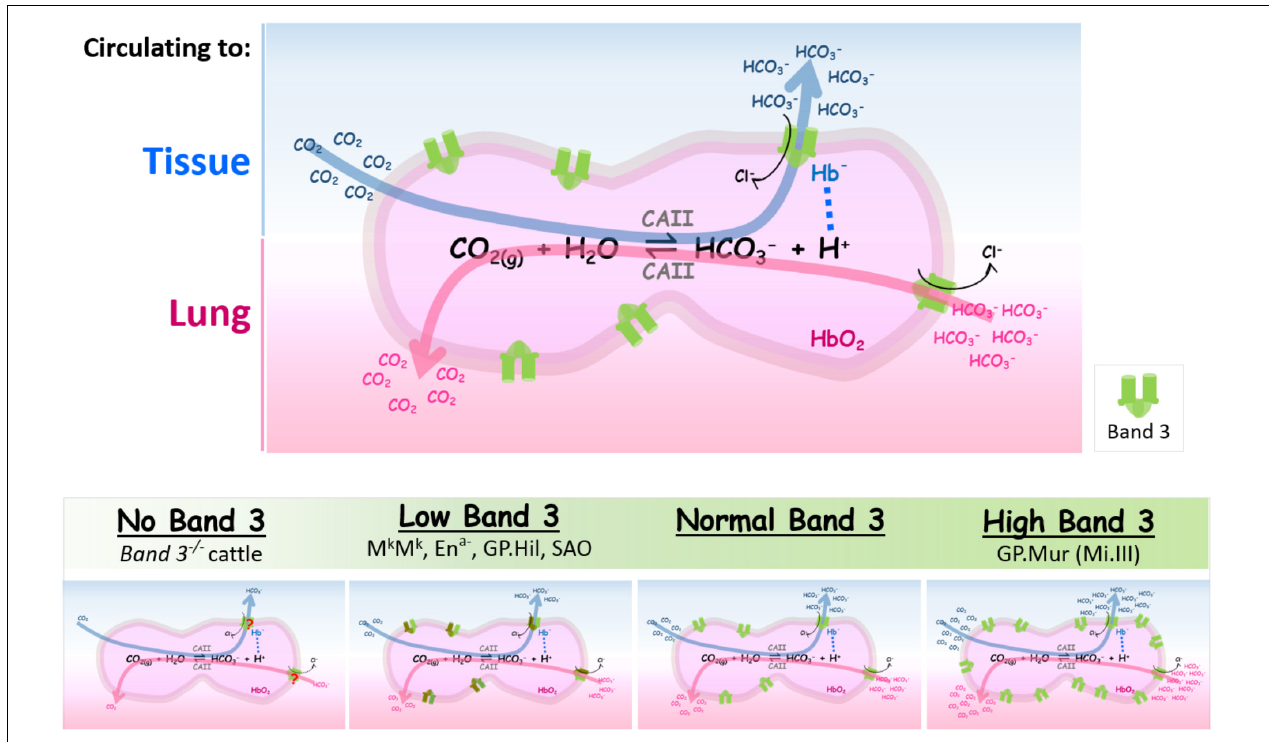
FIGURE 2 | The expression levels of band 3 are directly correlated with the efficiencies of blood CO 2 /HCO 3 − exchange. (Top) Intraerythrocytic CO 2 /HCO 3 − exchange in tissues or in lung alveoli is summarized in the reversible chemical reaction catalyzed by CAII [CO 2 ( g ) + H 2 O (cid:10) HCO 3 − ( aq ) + H + ( aq ) ]. When RBCs circulate to systemic capillaries, tissue metabolite CO 2 enters RBCs to be converted into HCO 3 − by intraerythrocytic CAII. HCO 3 − , one of the two products from this forward reaction, exits from RBCs through band 3 (shown by the blue arrow which indicates the direction of the reaction in tissues). The direction of the counterion Cl − flux through band 3 is indicated by a black arrow. Proton, the other product generated by the forward reaction, is absorbed by deoxy Hb − that is transiently associated with band 3 (shown by a dotted line connecting Hb − and H + ). When RBCs circulate to the lungs, HCO 3 − rushes into RBCs to be converted into CO 2 for expiration (shown by the pink arrow which indicates the reverse direction of the reaction). Band 3 is symbolized as the green dimeric gate. (Bottom) The spectrum of band 3 expression levels in RBCs is outlined in the shaded green bar; their differential impacts on blood CO 2 transport are illustrated in the four cartoon diagrams below. The four bottom diagrams from left to right: (1) Absence of band 3 reduces much HCO 3 − transport across the RBC membrane, rendering CO 2 /HCO 3 − exchange to be very inefficient. (2) Low band 3 expression can be found in some band 3/GPA mutations that result in semi-dysfunctional band 3 transporters, as described in the section of “Low or no band 3 expression” (shown here by the brown/green gate symbols for “structurally abnormal band 3”). (3) Normal band 3 expression. (4) Higher band 3 expression in GP.Mur RBCs (shown by more green gates on the cell membrane) increases the efficiency as well as the capacity of intraerythrocytic CO 2 /HCO 3 − conversion and HCO 3 − transport across the RBC membrane. The different numbers of CO 2 /HCO 3 − in the bottom four diagrams represent schematically the different magnitudes of CO 2 /HCO 3 − fluxes (metabolic flows) that correspond to the different levels of band 3 expression on the red cell membrane; they do not reflect extracellular concentrations of CO 2 and HCO 3 −